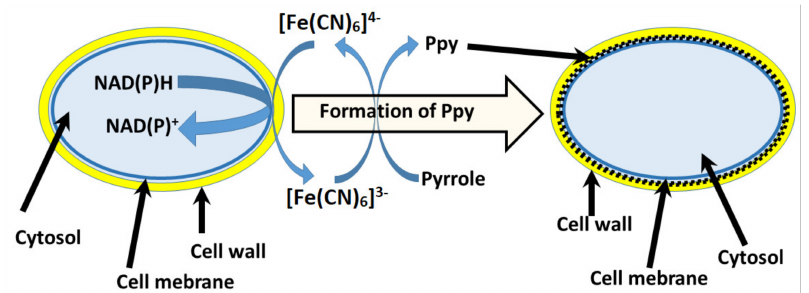
Figure 5. Schematic representation of Ppy synthesis in cell wall of yeast [10]; Redox enzymes that are located in plasma membrane are oxidizing [Fe(CN)6] 4 − into [Fe(CN)6] 3 − that is inducing polymerization reaction of pyrrole